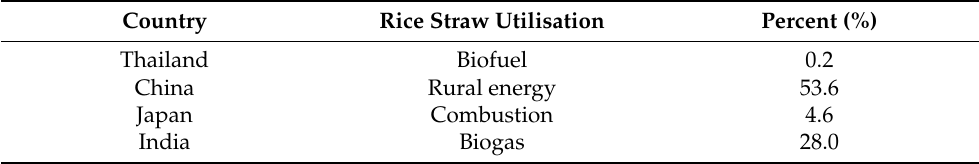
Table 2. Rice straw utilisation for bioenergy in Asia